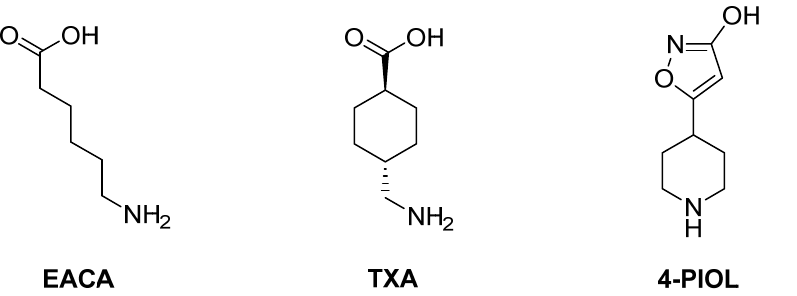
Figure 1. Previously studied small molecules with antifibrinolytic activity by inhibition of the lysine binding sites of plasminogen.